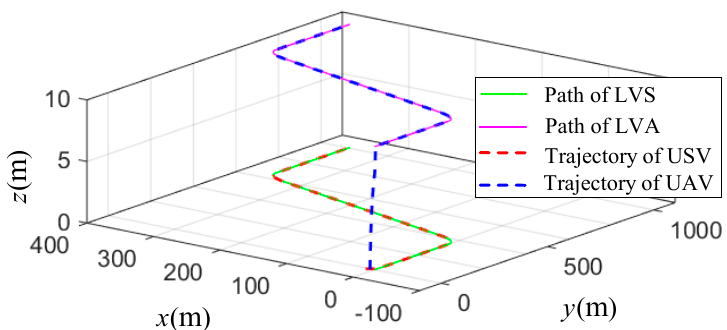
Figure 4. The trajectories for the USV-UAV under the LVS-LVA guidance.